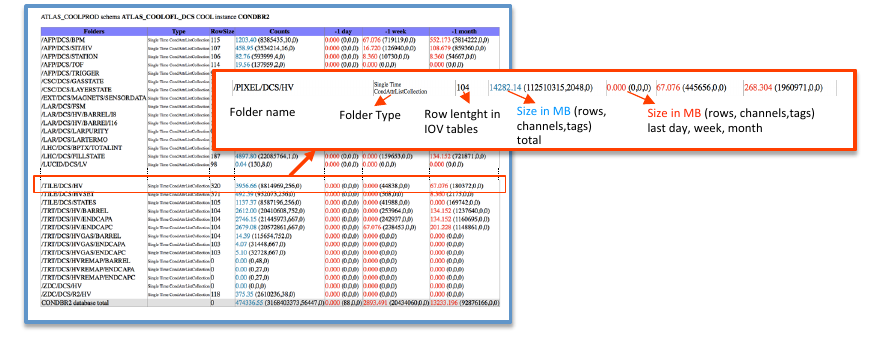
Figure 1. Snapshot of the list of ATLAS COOL production database instances